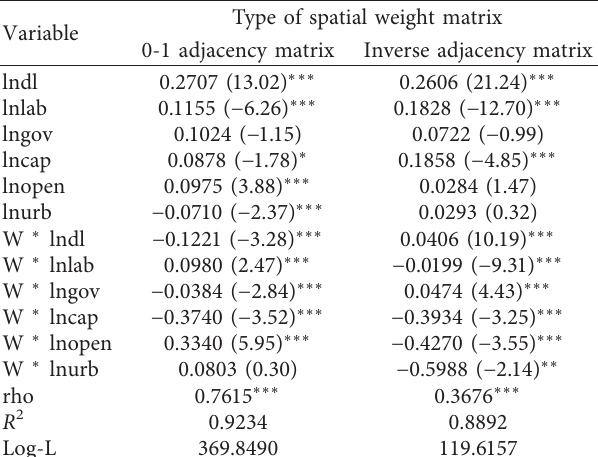
Table 8: Robustness test of the